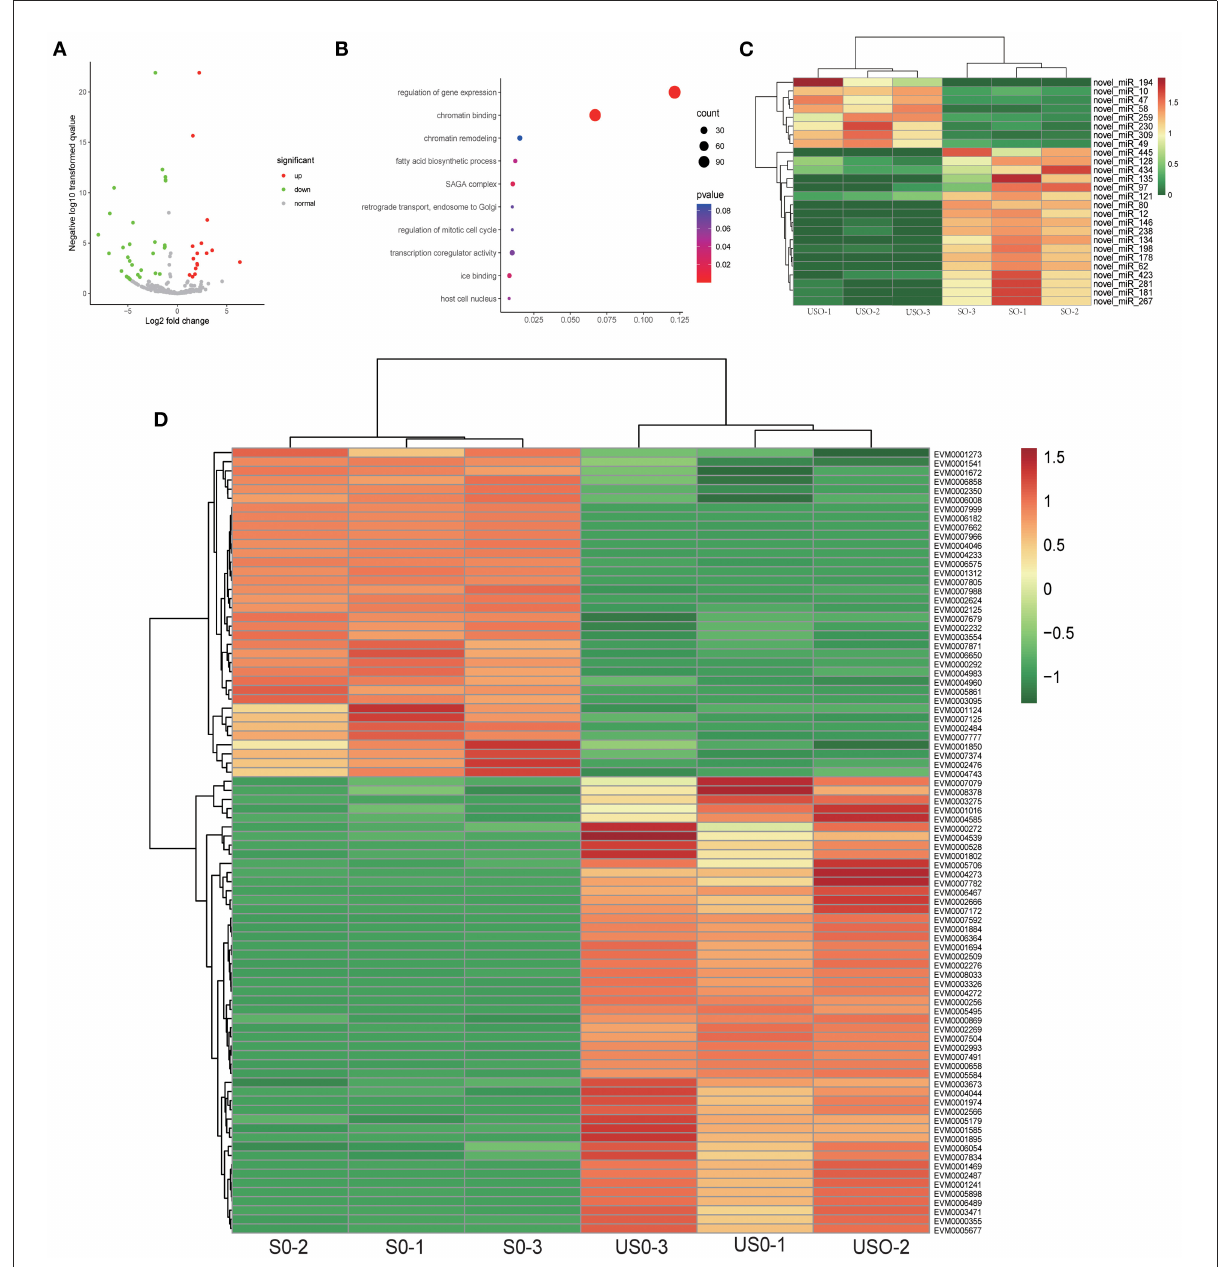
FIGURE4 Target gene analysis of differentially expressed miRNAs in USO vs. SO. (A) Volcano plot showing differentially expressed miRNAs between USO (unsporulated oocysts) and SO (sporulated oocysts). (B) Go enrichment plot of target genes for differentially expressed miRNAs in USO vs. SO. Only the 10 GO functions with the smallest p -value were taken for statistical purposes. (C) Heatmap showing DEGs (differentially expressed genes of targets) of differentially expressed miRNAs enriched in gene expression regulation and chromatin binding pathway. (D) Heatmap showing differentially expressed miRNAs enriched in gene expression regulation and chromatin binding